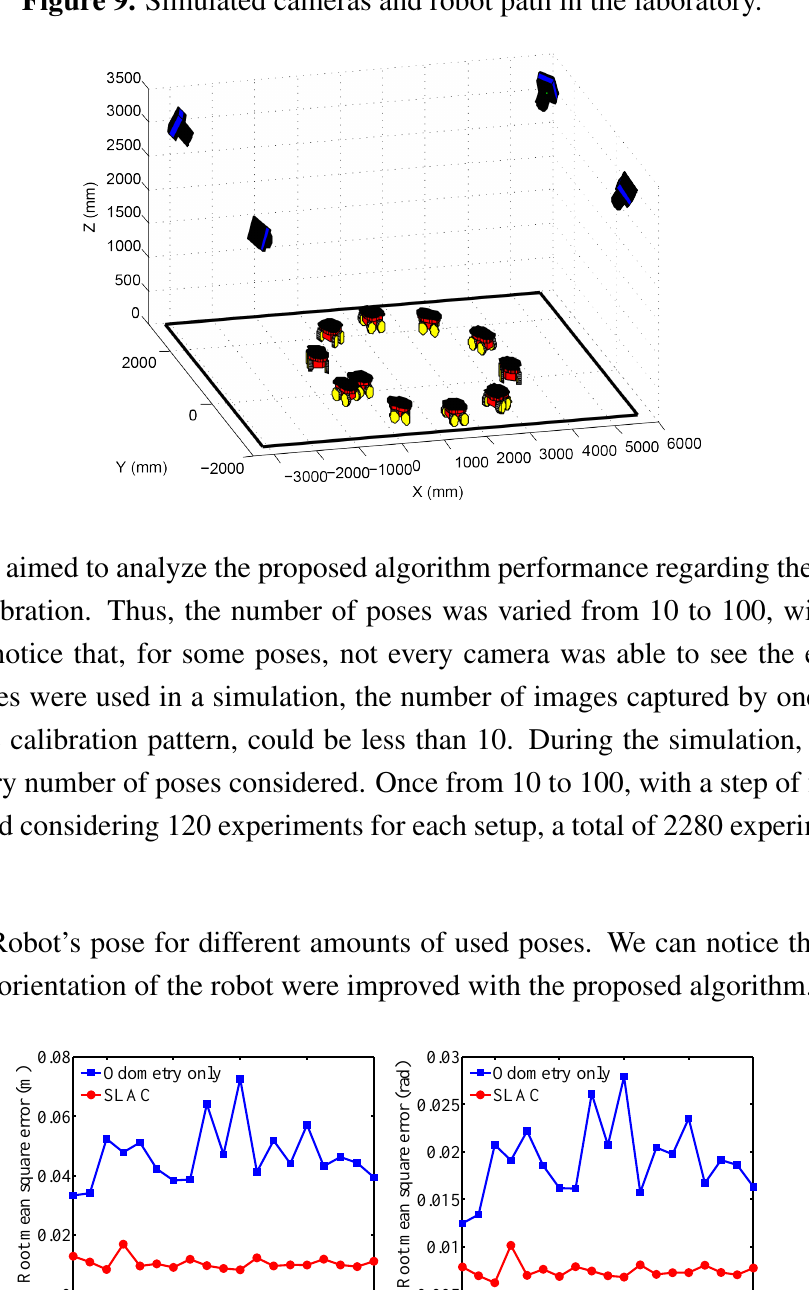
Figure 9. Simulated cameras and robot path in the laboratory.